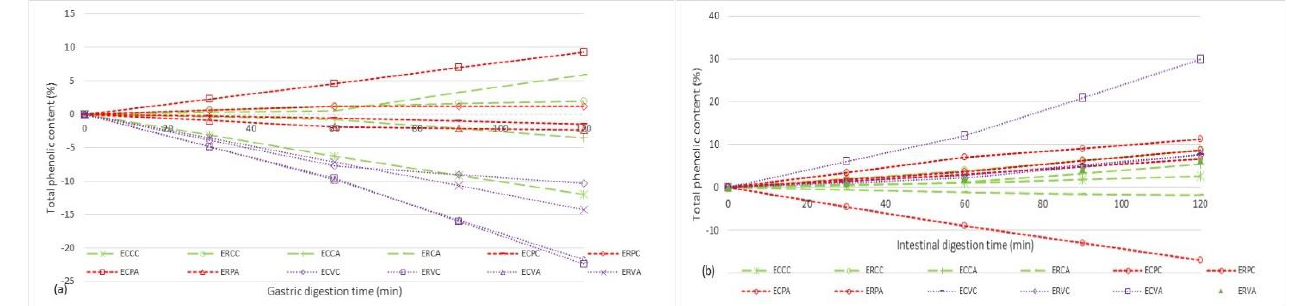
Figure 2. The in vitro digestion of remanent polyphenolic content in meatball samples in simulated gastric juice ( a ) and simulated intestinal juice ( b ); ECPC and ECPA are pork meatballs enriched with wild thyme aqueous extract, processed by hot air and steam convection; ERPC and ERPA are pork meatballs enriched with lemon balm aqueous extract, processed by hot air and steam convection; ERCC and ERCA are turkey meatballs enriched with lemon balm aqueous extract, processed by hot air and steam convection; ECVC and ECVA are beef meatballs enriched with wild thyme aqueous extract, processed by hot air and steam convection; ERVC and ERVA are beef meatballs enriched with lemon balm aqueous extract, processed by hot air and steam convection.